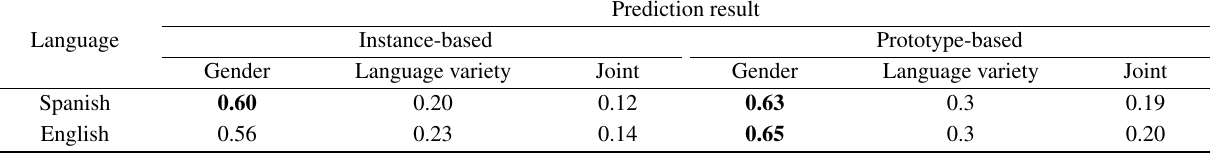
Table 8 Prediction results obtained using instance-based and prototype-based strategies by Adame-Arcia et al. [47]